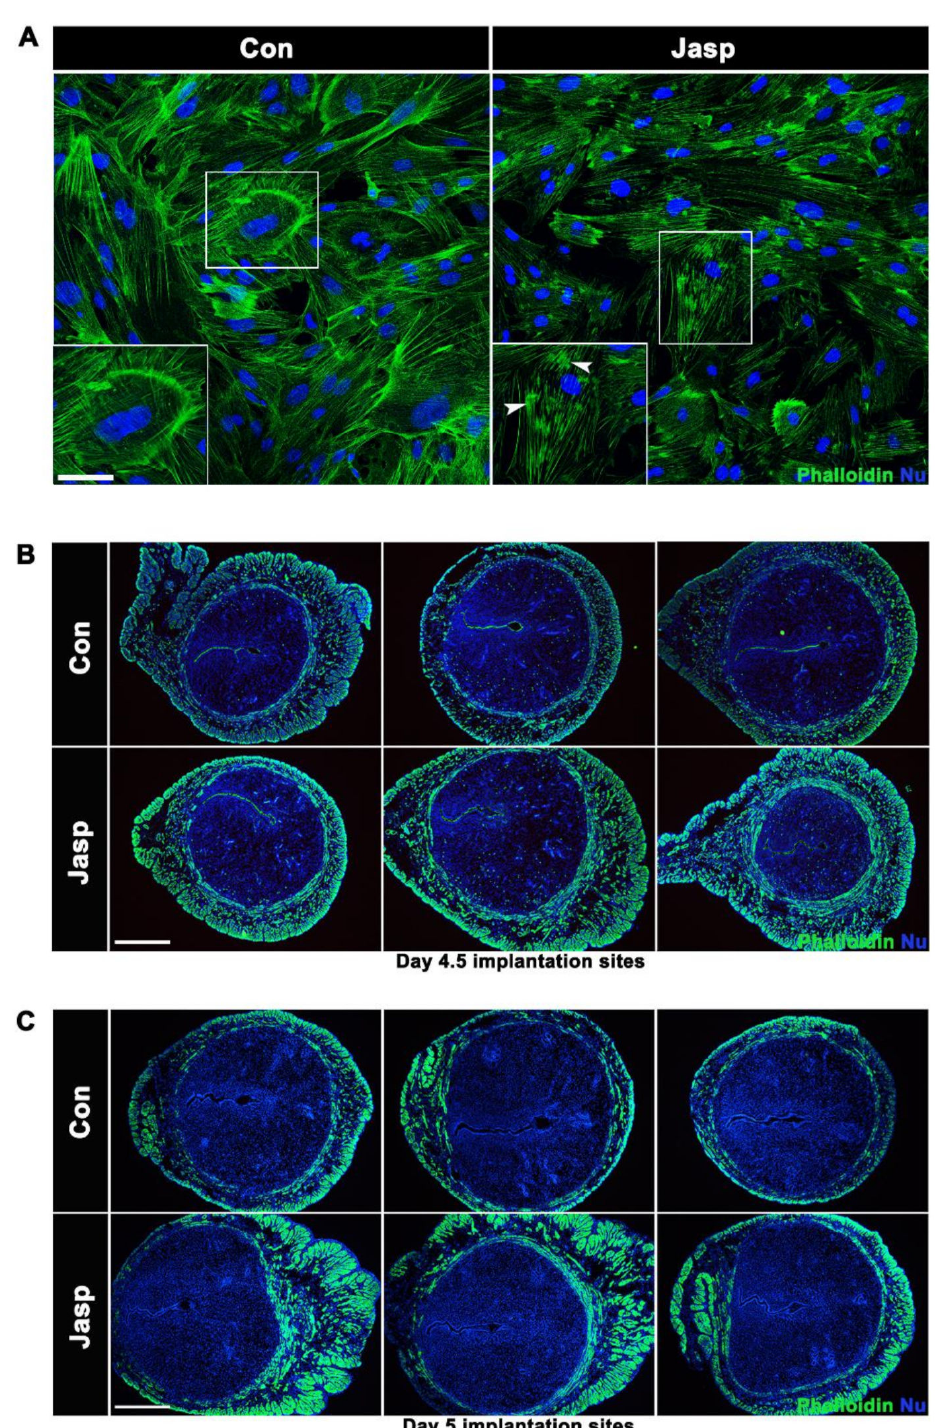
Figure 2. Jasp promotes F-actin accumulation in uterine smooth muscle. ( A ) Phalloidin staining of mice uterine SMCs treated with 100 nM Jasplakinolide for 24 h on day 3 of pregnancy. Scale bars = 200 µ m. ( B , C ) Mice were intraperitoneally injected with Jasp 10 µ g/mice at 09:00 am on day 3 of pregnancy, and uteri were collected on days 4.5 and 5 of pregnancy. Phalloidin (green), DAPI (blue). Scale bars = 500 µ